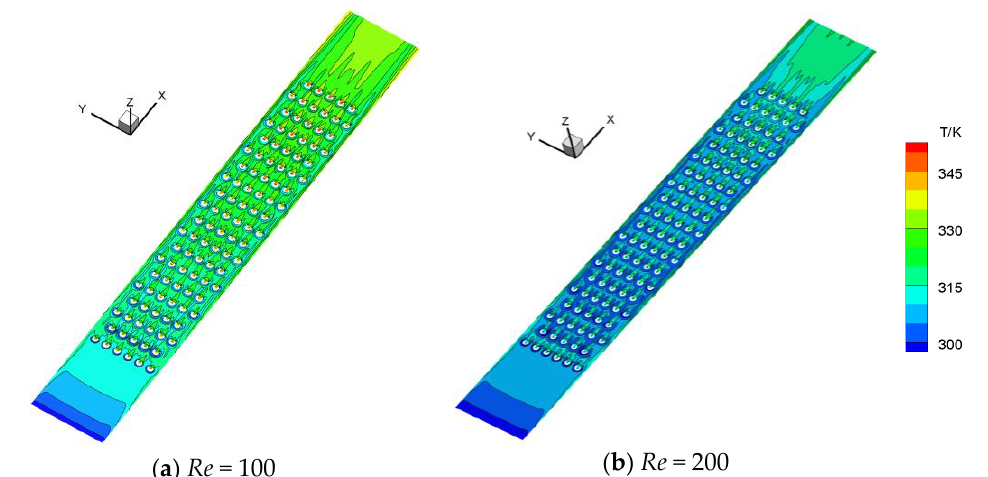
Figure 10. Temperature distribution in the ring-shaped micro-pin-fin array.